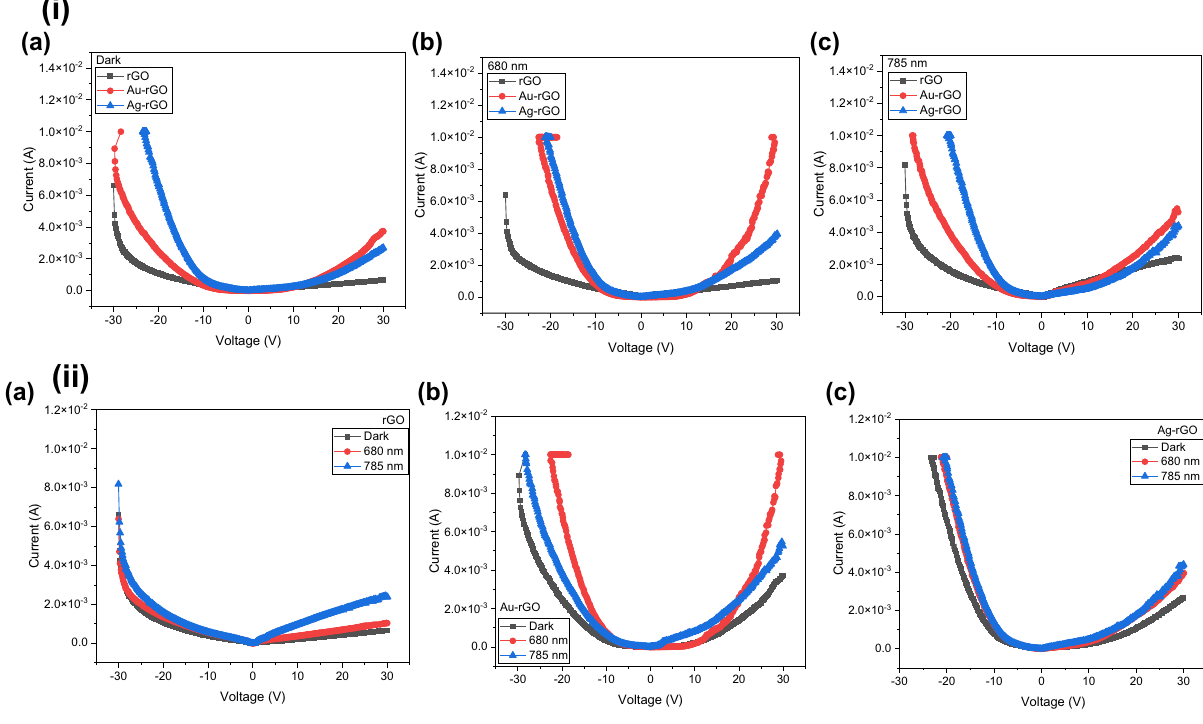
Figure 3. Current–voltage (I–V) curves (i) ( a ) by condition as at dark, ( b ) 680 nm and ( c ) 785 nm illumination and (ii) by device comparison as ( a ) bare-rGO, ( b ) Au-rGO and ( c )